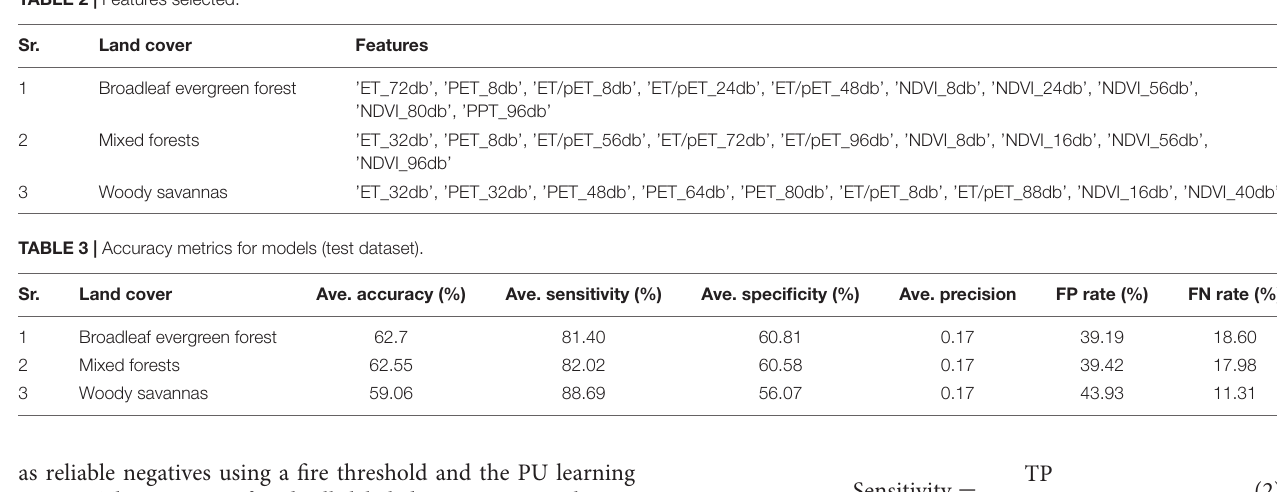
FIGURE 4 | Verification results of models for each of the three land covers. “Combined” refers to the collective percentage of verification fires in all the three land covers studied. (A) Fires with low confidence level ( > 80%), and (B) fires with higher confidence level ( > 95%). TABLE 2 | Features selected.